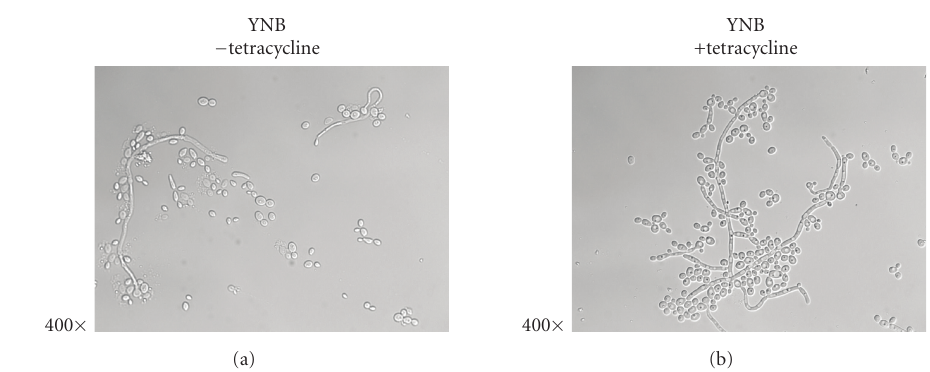
Figure 2: Photomicrographs of Candida albicans (Strain GT142) grown overnight at 37 ◦ C in YNB or YNB plus tetracycline (5 μ g/mL). The yeast tended toward germination and filamentation in YNB, and tetracycline did not inhibit this tendency. Images are representative of many fields that indicate filamentous growth in the presence of tetracycline that is augmented and fungal masses appear larger than in control (YNB) cultures.